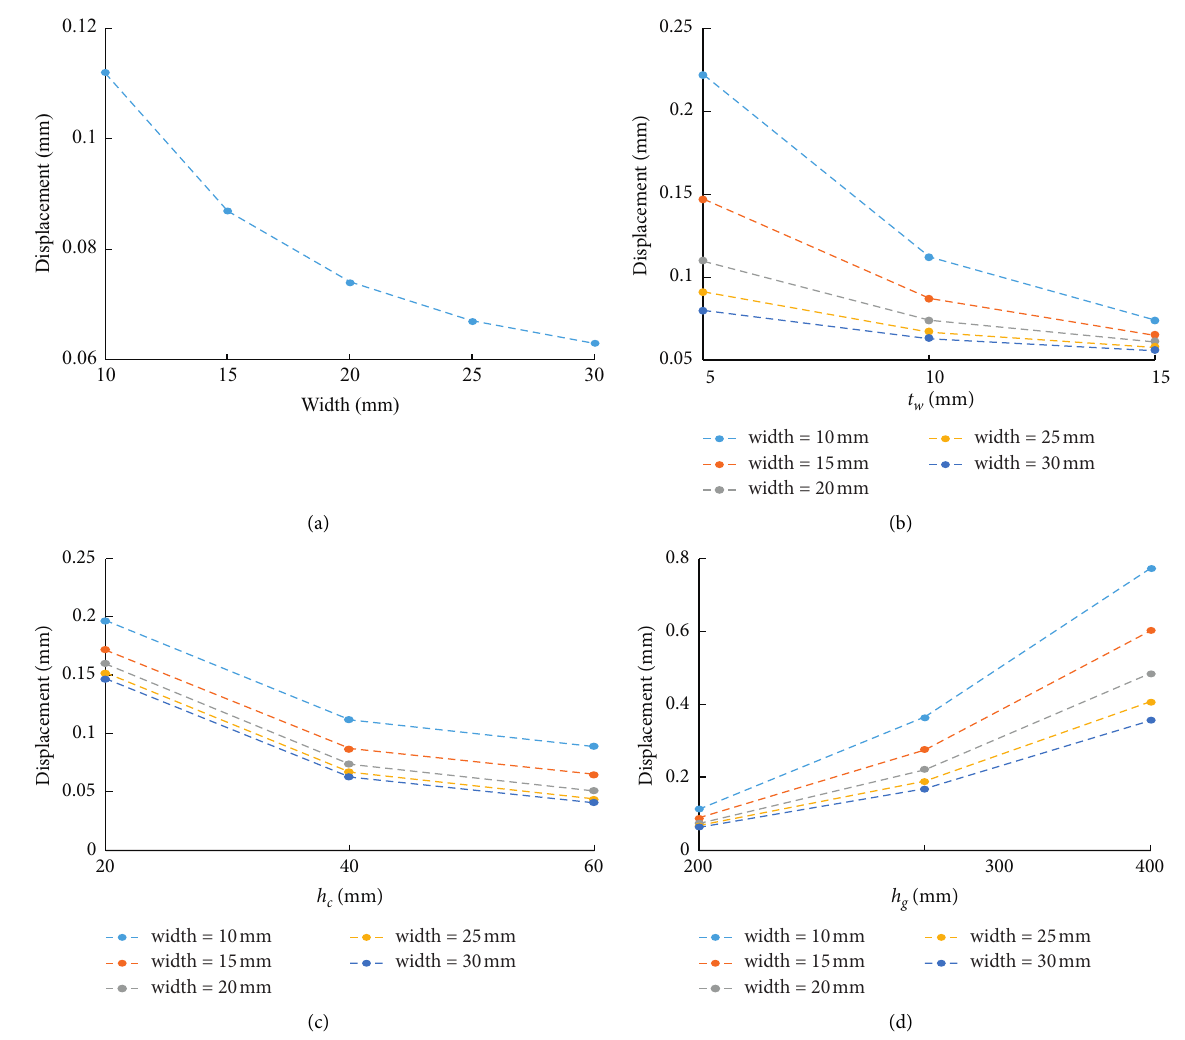
Figure 18: Lateral displacement of the two I-shaped GFRP with corrugated webs-concrete hybrid